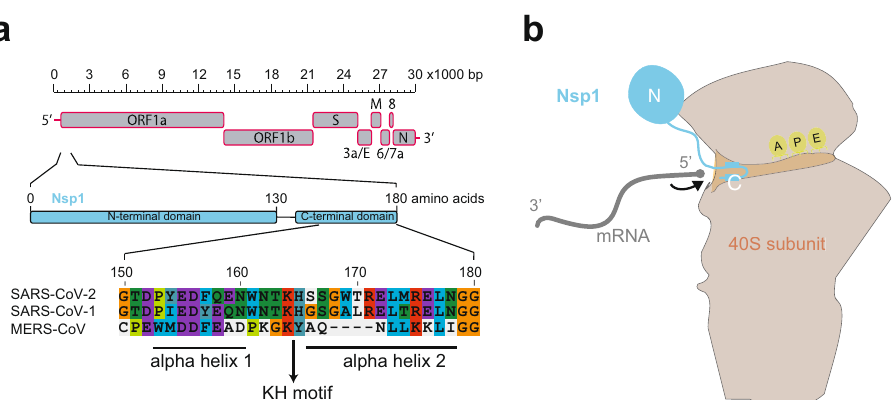
Fig. 1 Nsp1 interaction with the ribosome. a Schematic of SARS-CoV-2 genome organisation with the whole genome depicted at the top, Nsp1 coding sequence in the middle, and a sequence alignment of Nsp1 C-terminal domain of SARS-CoV-2, SARS-CoV-1, and MERS-CoV in the lower part of the panel. The two alpha helices and the KH motif are marked by bars and an arrow, respectively. Colour coding of amino acids corresponds to default settings of the ClustalX alignment tool. b Cartoon depicting the interaction between Nsp1 and the 40S ribosomal subunit, as revealed by the structural data. The C- terminal helices anchor Nsp1 in the mRNA entry channel, thereby blocking access for host transcripts (schematically represented in grey). The globular N- terminus is not suf fi ciently resolved in the structures to be able to assign a clear position and